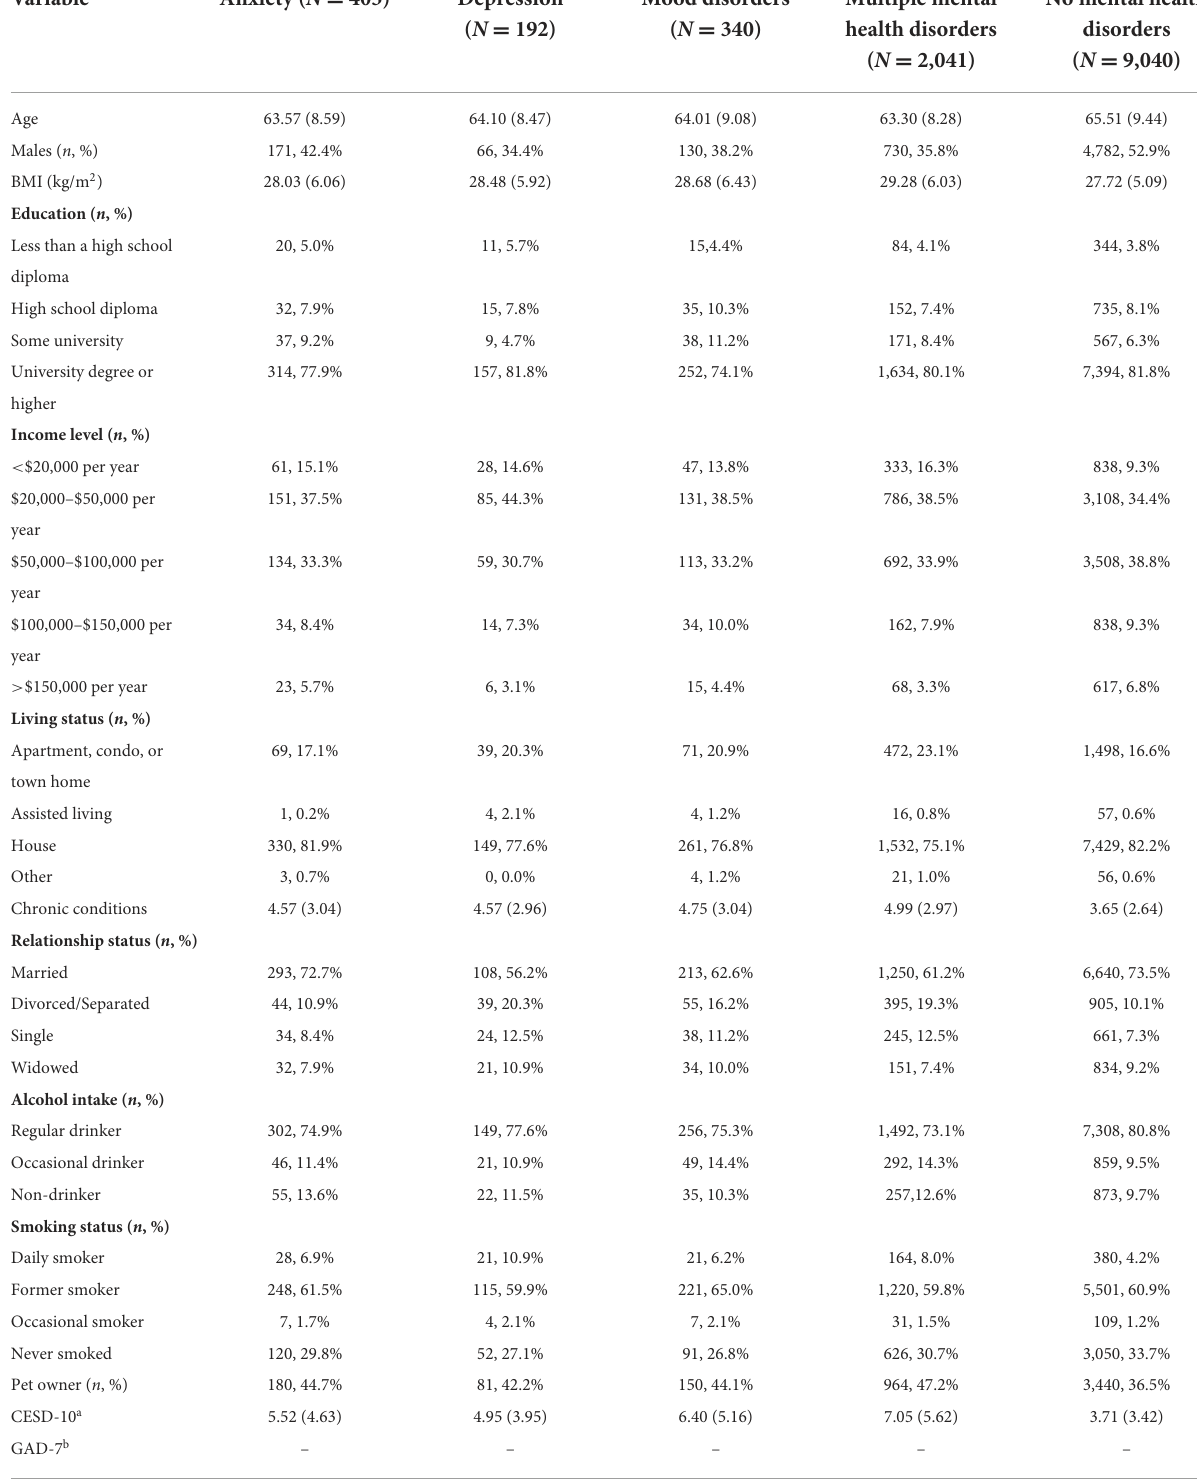
TABLE 3 Analyzed sample participant characteristics at first follow-up (2015–2018) by self-reported mental health disorder